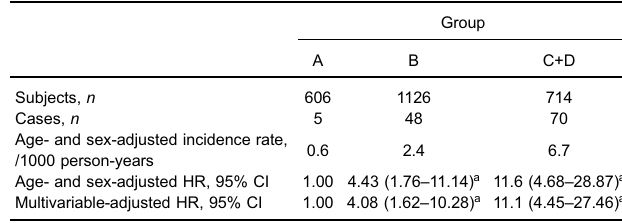
Table 2. Adjusted incidence rate and hazard ratio with 95% con fi dence interval for gastric cancer according to the combination of Helicobacter pylori antibody and serum pepsinogen